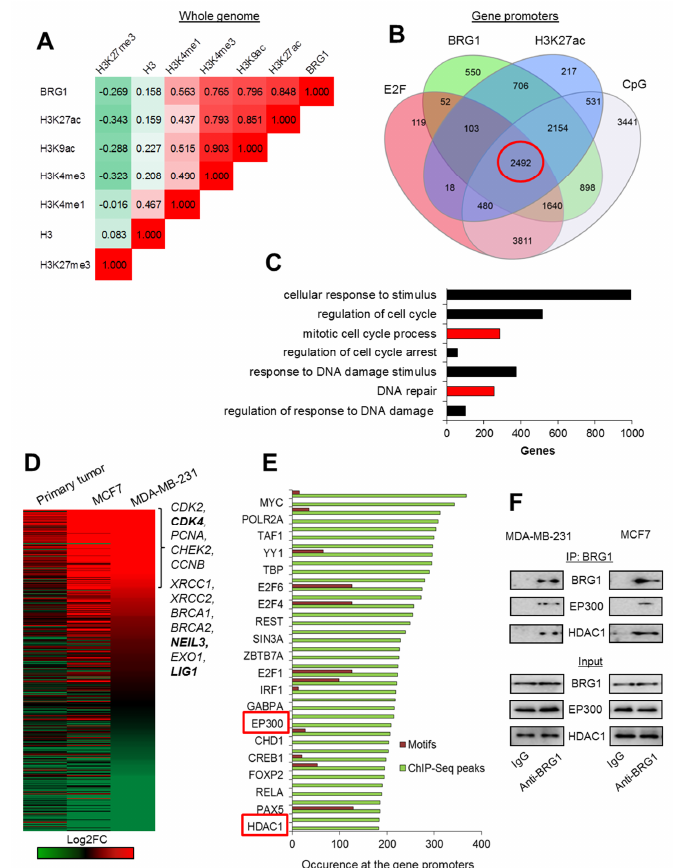
Figure 1. BRG1 occurs at the acetylated promoters of some highly transcribed genes, which control proliferation and DNA repair in breast cancer cells. ( A ) BRG1 co-distribution with histone H3 density and histone modifications in the genome of MDA-MB-231 is shown as Pearson’s correlation coe ffi cient. ( B ) Occurrence of BRG1 at the acetylated gene promoters characterized by E2F binding site and CpG island has been quantified on a Venn diagram and BRG1 / H3K27ac / E2F / CpG promoters are marked in red circle. Green and blue circles represent gene promoters enriched in BRG1 and H3K27ac peaks according to MACS, while grey and red represent promoters featured by the presence of CpG islands according to cpgIslandExt and E2F binding motifs according to cpgIslandExt and wgEncodeRegTfbsClusteredV3, respectively. ( C ) Functional association of BRG1 / H3K27ac / E2F / CpG gene promoters (marked in red circle in ( B ) leads to enrichment of intracellular processes that can define cancer physiology. Red bars represent biological processes, which are taken for further analysis in ( D , E ). ( D ) Analysis of di ff erential gene expression from data derived from RNA-Seq confirms overexpression of genes functionally assigned to the mitotic cell cycle and to responses to stimuli of DNA damage in cancer cell lines versus normal breast cells. Genes marked in bold were taken as examples for further analysis in Figure 2A–D. ( E ) BRG1 / H3K27ac / E2F / CpG promoters of genes overexpressed in cancer cells ( D ): Log2FC > 0.5 for at least 2 of the cell types used are characterized by common transcription factors and chromatin remodelers. Green columns correspond to the number of ChIP-Seq peak occurrences at the gene promoters according to UCSC wgEncodeRegTfbsClusteredV3, whereas red columns represent the occurrence of transcription factor binding motifs according to tfbsConsSites. Only every other transcription factor is labeled. ( F ) Immunoprecipitation of BRG1 allows to detect EP300 and HDAC1 by western blot and indicates the physical interaction between SWI / SNF component and the latter two enzymes. Pictures show cropped areas of western blots. Whole images are included in Figure